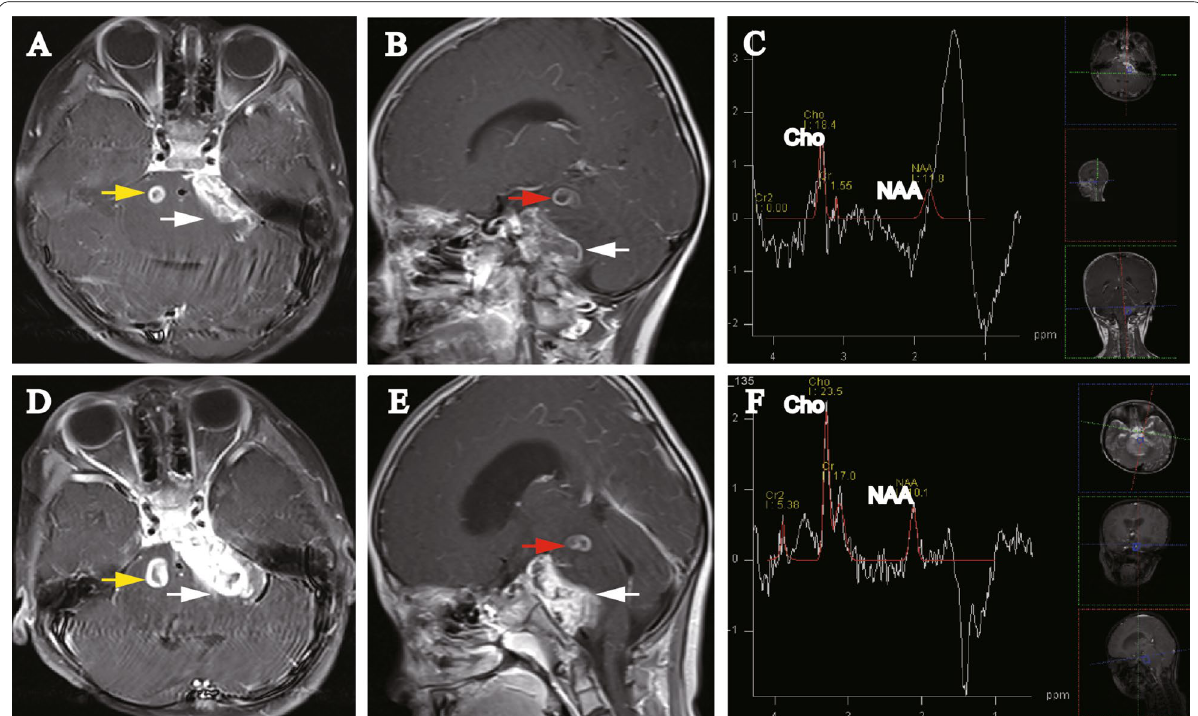
Fig. 2 Images of repeated MRI on Dec 11, 2015 and Jan 12, 2016 for the 5-year-old girl with multiple posterior fossa lesions. A Axial gadolinium- enhanced MRI (Dec 11, 2015) displays the occurrence of a new lesion (0.8 cm 0.9 cm, yellow arrow ). The left CPA lesion is enlarged and extended × along the cistern of the CPA (3.1 cm 1.2 cm, white arrow ). B Sagittal gadolinium-enhanced MRI (Dec 11, 2015) shows that the CPA lesion was × enlarged and extended along the cistern of CPA ( white arrow ) and the upper left pontine lesion was enlarged ( red arrow ). C MRS (Dec 11, 2015) shows increased Cho and decreased NAA expression. The Cho:NAA ratio was also significantly increased. D Axial gadolinium-enhanced MRI (Jan 12, 2016) displays that both the CPA lesion ( white arrow ) and the new lesion in the right side of the pons are enlarged (1.1 cm 1.3 cm, yellow arrow ). × The CPA lesion is extended along the cistern of the CPA. E Sagittal gadolinium-enhanced MRI (Jan 12, 2016) shows that both the CPA lesion ( white arrow ) and upper left pontine lesion ( red arrow ) were enlarged. F MRS (Jan 12, 2016) shows further increased Cho and decreased NAA expression. The Cho:NAA ratio was